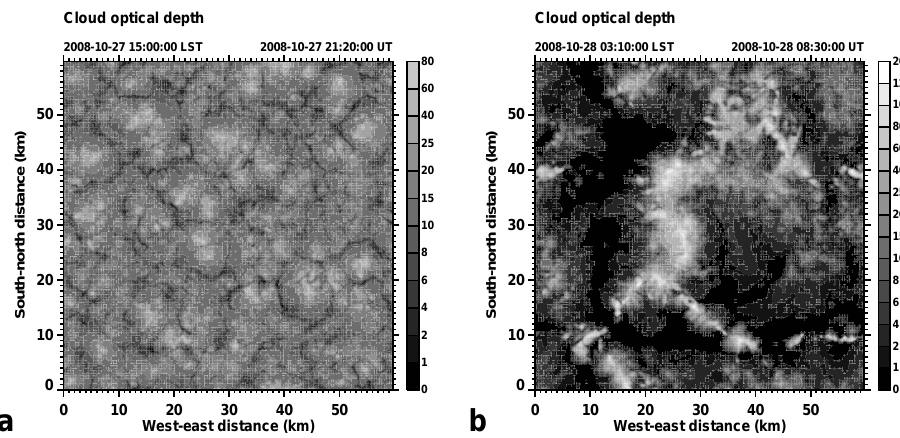
Fig. 2. Cloud optical depth in simulation S 0 . Initially, the cloud field exhibits high optical depths in cell centers and reduced optical depths along the cell peripheries, characteristic of closed-cell circulation (a) . Approximately 12h later, the cloud field has developed open-cell circulation with high optical depths along the cell peripheries, and reduced optical depths in the cell centers (b) .